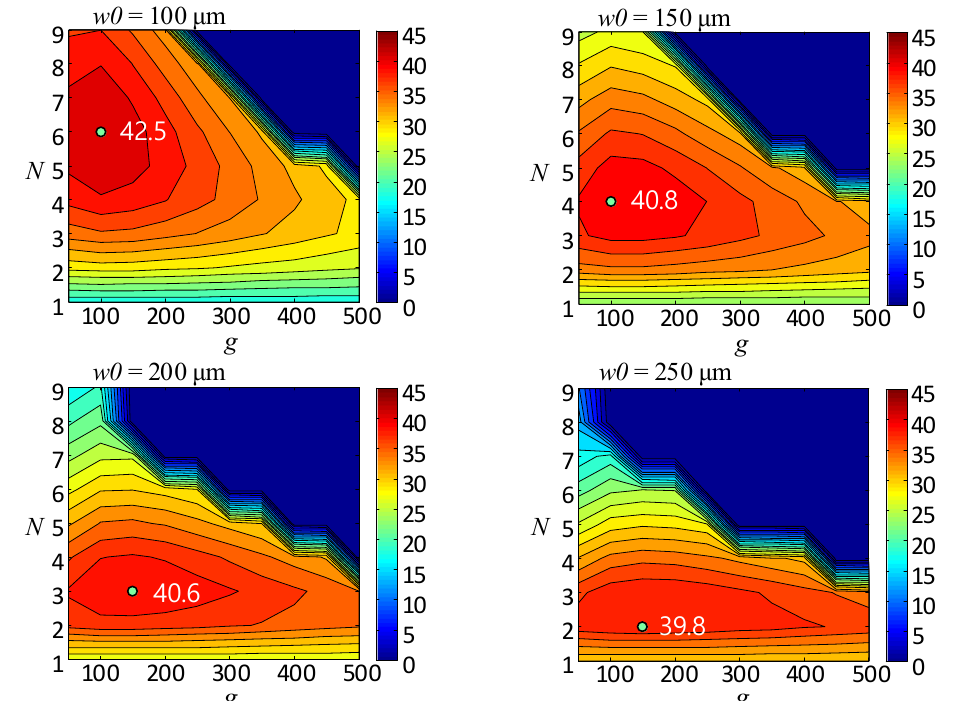
Figure 8. The calculated Q-factor according to g and N for the four-layer planar spiral coil for w 0 = 0.1, 0.15, 0.2, and 0.25 mm.